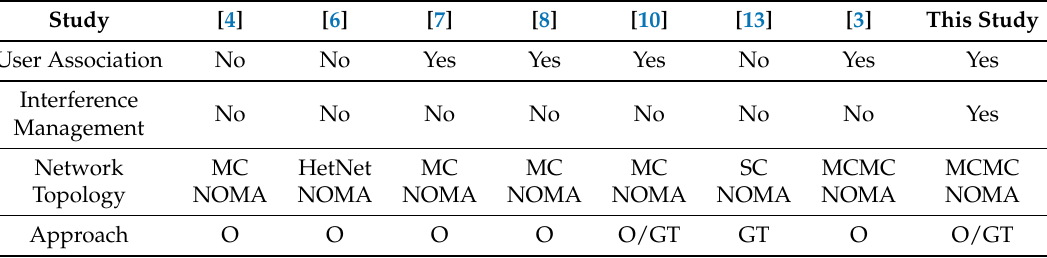
Table 1. Comparison of different related